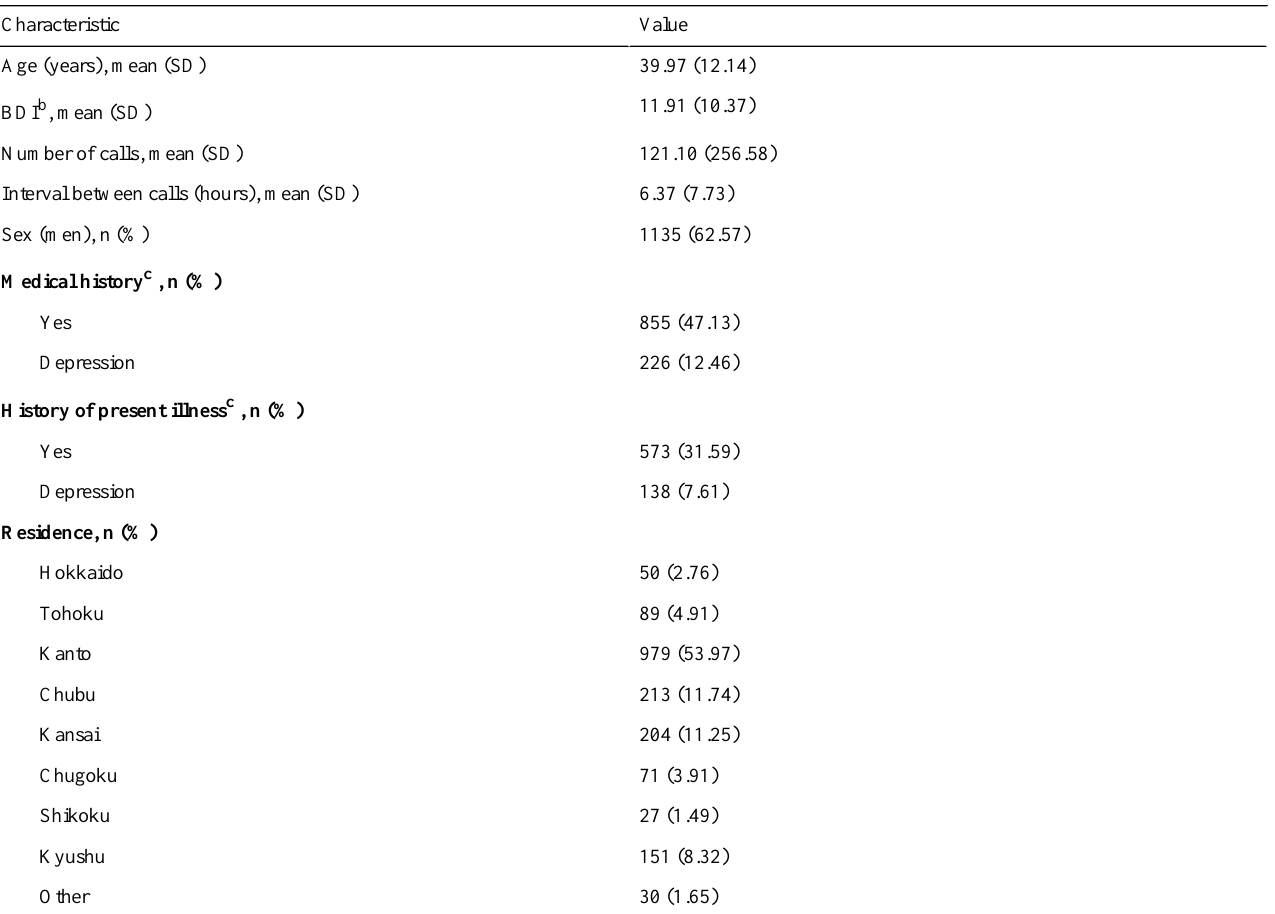
Table 1. Detailed information of MIMOSYS a participants